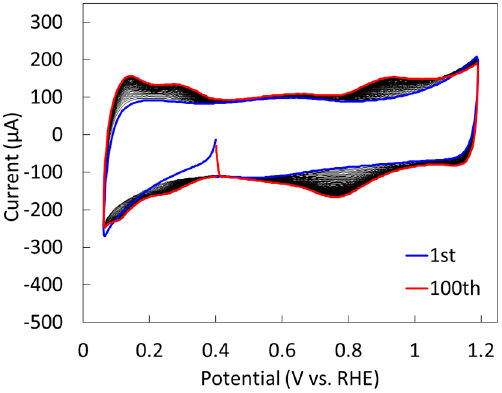
Figure 16. Cyclic Voltammograms during the reactivation potential cycles.